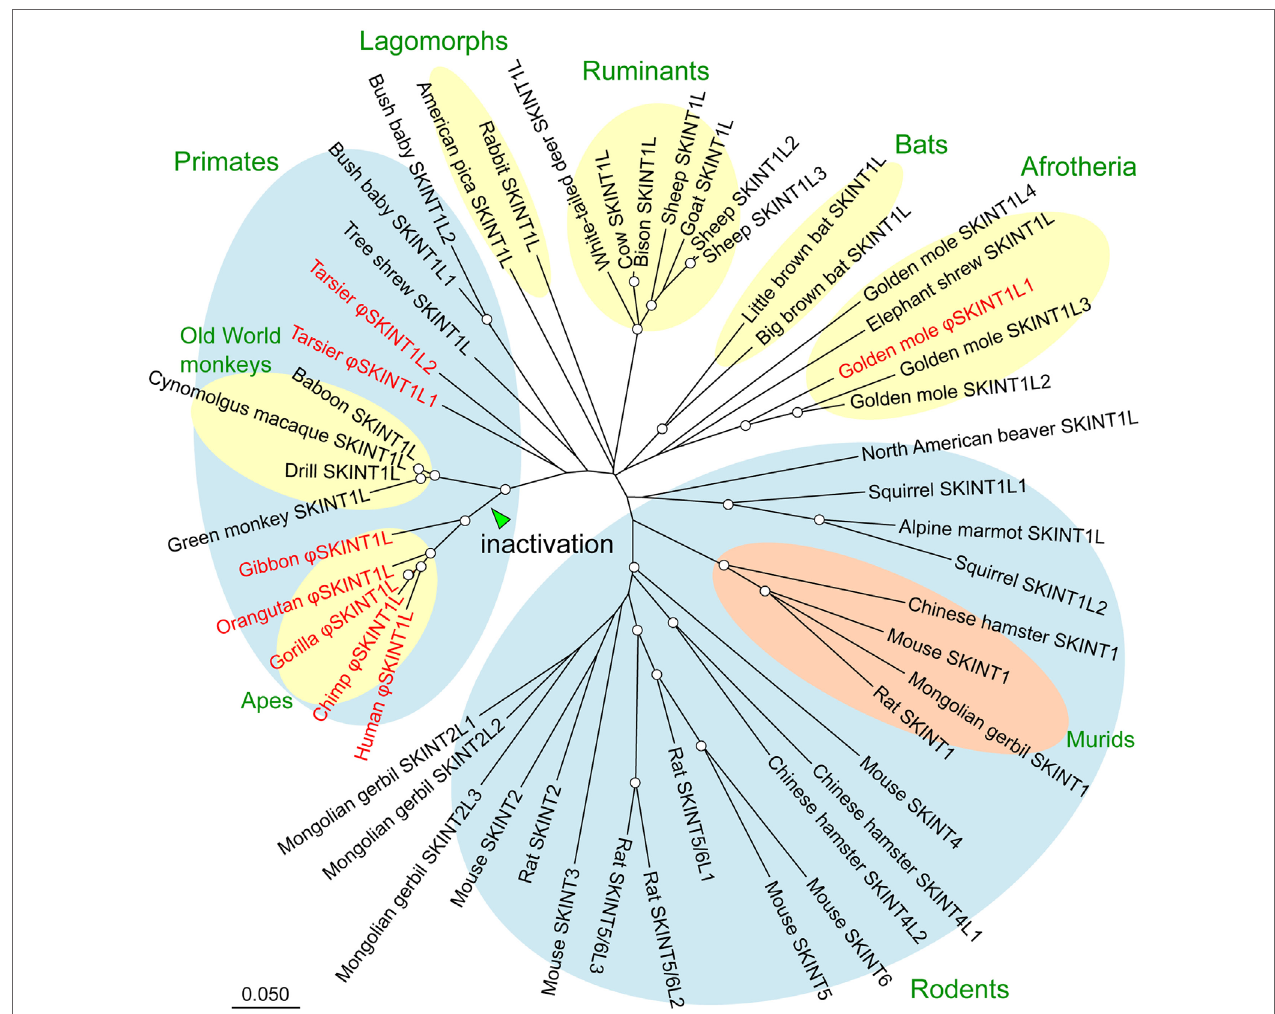
FiGURe 1 | Phylogenetic tree of the SKINT1 subfamily. SKINT1 subfamily sequences were retrieved from the NCBI database (WGS and nr databases) using the mouse Skint1 sequence as a query. Deduced amino acid sequences of SKINT1 subfamily proteins were aligned, and the phylogenetic tree was constructed using the MUSCLE and neighbor-joining programs implemented in MEGA7, respectively. The distance matrix was obtained by calculating p-distances for all pairs of sequences. Gaps were excluded using the pairwise-deletion option. The reliability of branching patterns was assessed by bootstrap analysis (1,000 replications). Pseudogenes are indicated by φ and shown in red. Nodes supported by bootstrap values over 80% are indicated by open circles. Skint7 to Skint11 genes of mice are not shown as they are the members of the SKINT7 or SKINT9